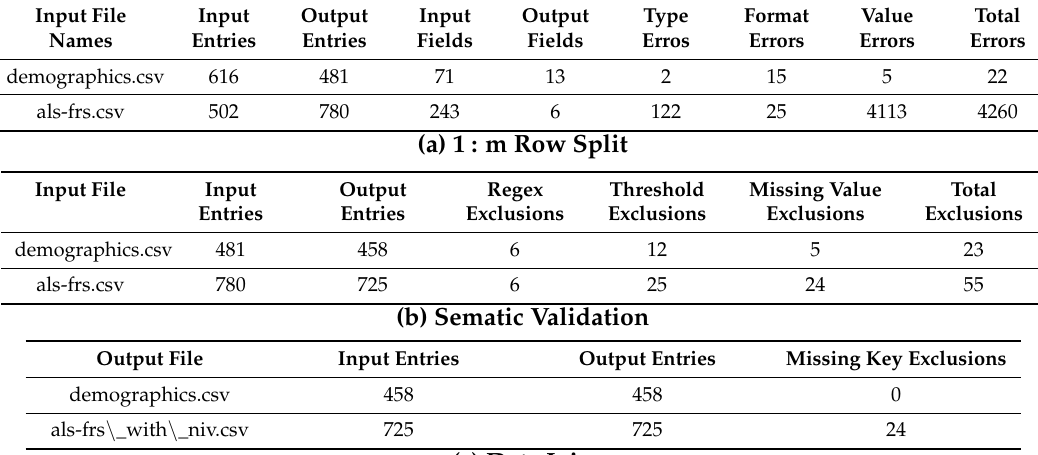
Table 12. Transparency Report for the three phases of the proposed ETL framework. Field mapping, semantic validation, and join transformation are described from a data integration point of view through multiple information fields, including the number of applied transformations, missing values count, and type or format